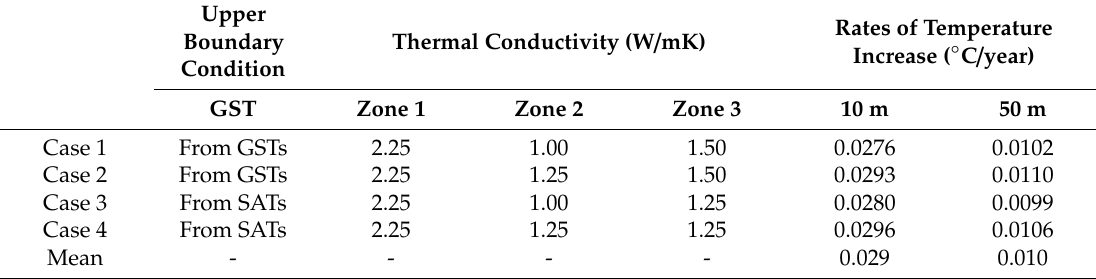
Table 3. Summary of thermal conductivity data and rates of temperature increase ( ◦ C / year) for each case for approximately 10